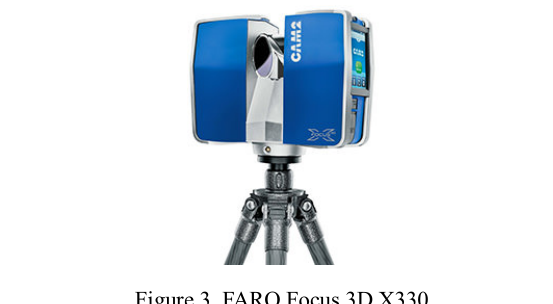
Figure 3. FARO Focus 3D X330